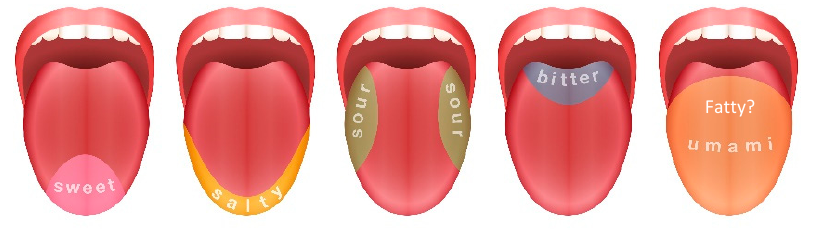
Figure 1. Scheme of human tongue and taste receptors position.